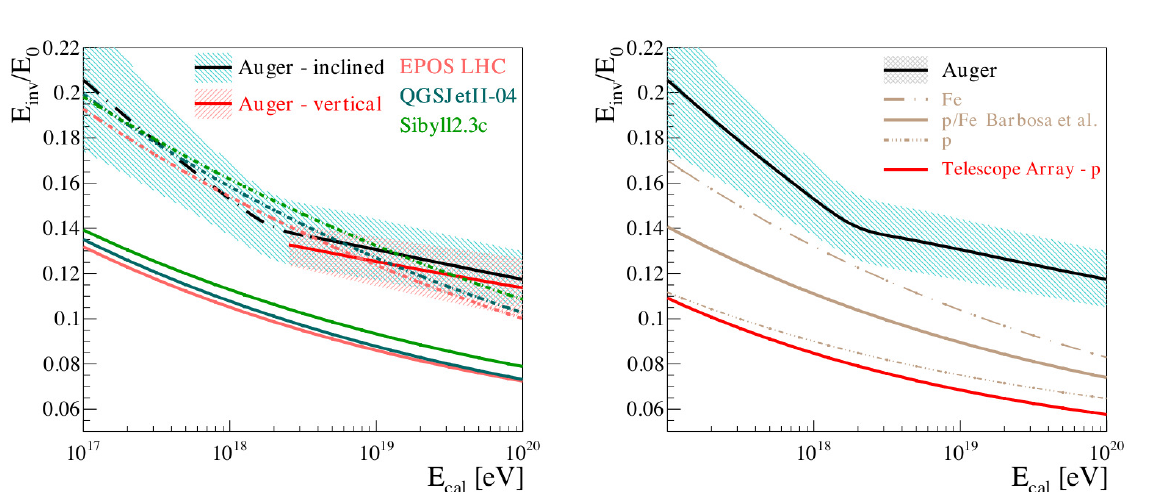
Figure 6. Left: E inv for inclined and vertical events compared with predictions from simulations. Systematic uncertainty are shown with the shaded bands. The estimate for inclined events is extrapolated to low energies. Right:Auger data-driven estimation of E inv compared with the parameterisations for protons, iron and mixed composition reported in [1] and the one in use by Telescope Array